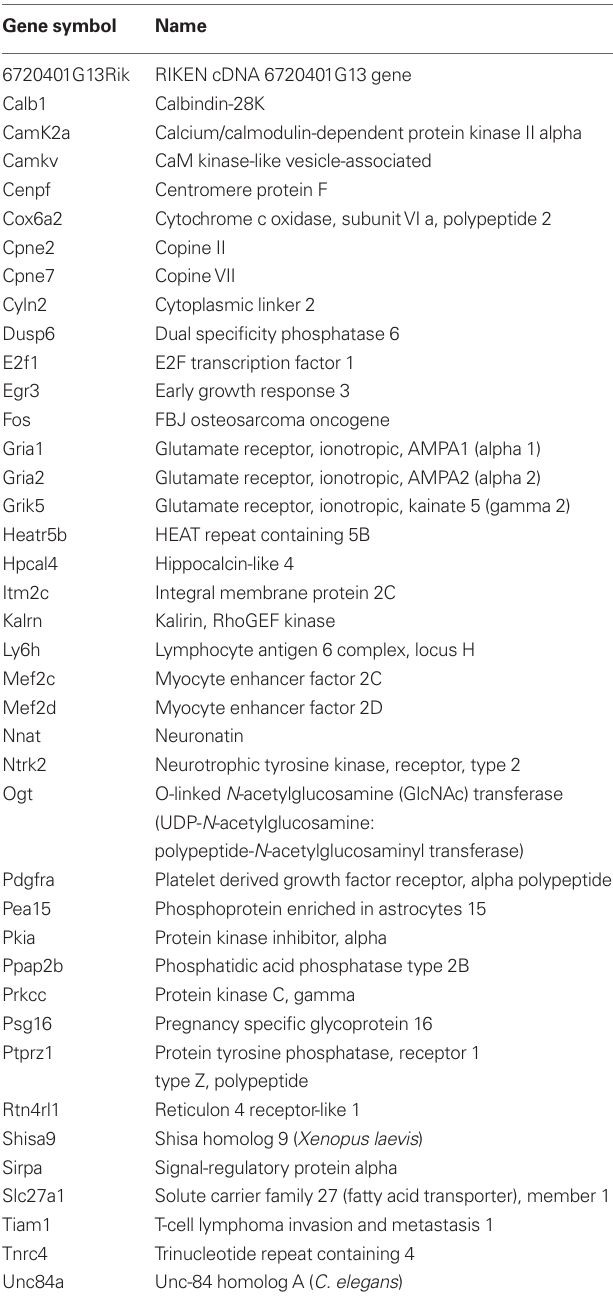
Table 1 | Pattern Ne gene symbols and